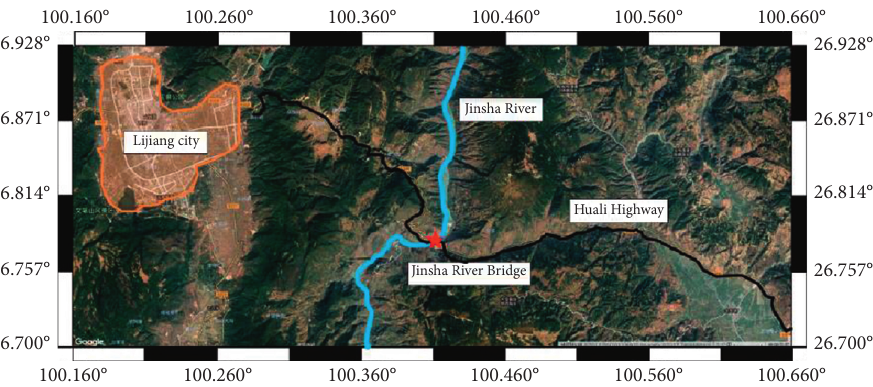
Figure 1: Location of the study area.